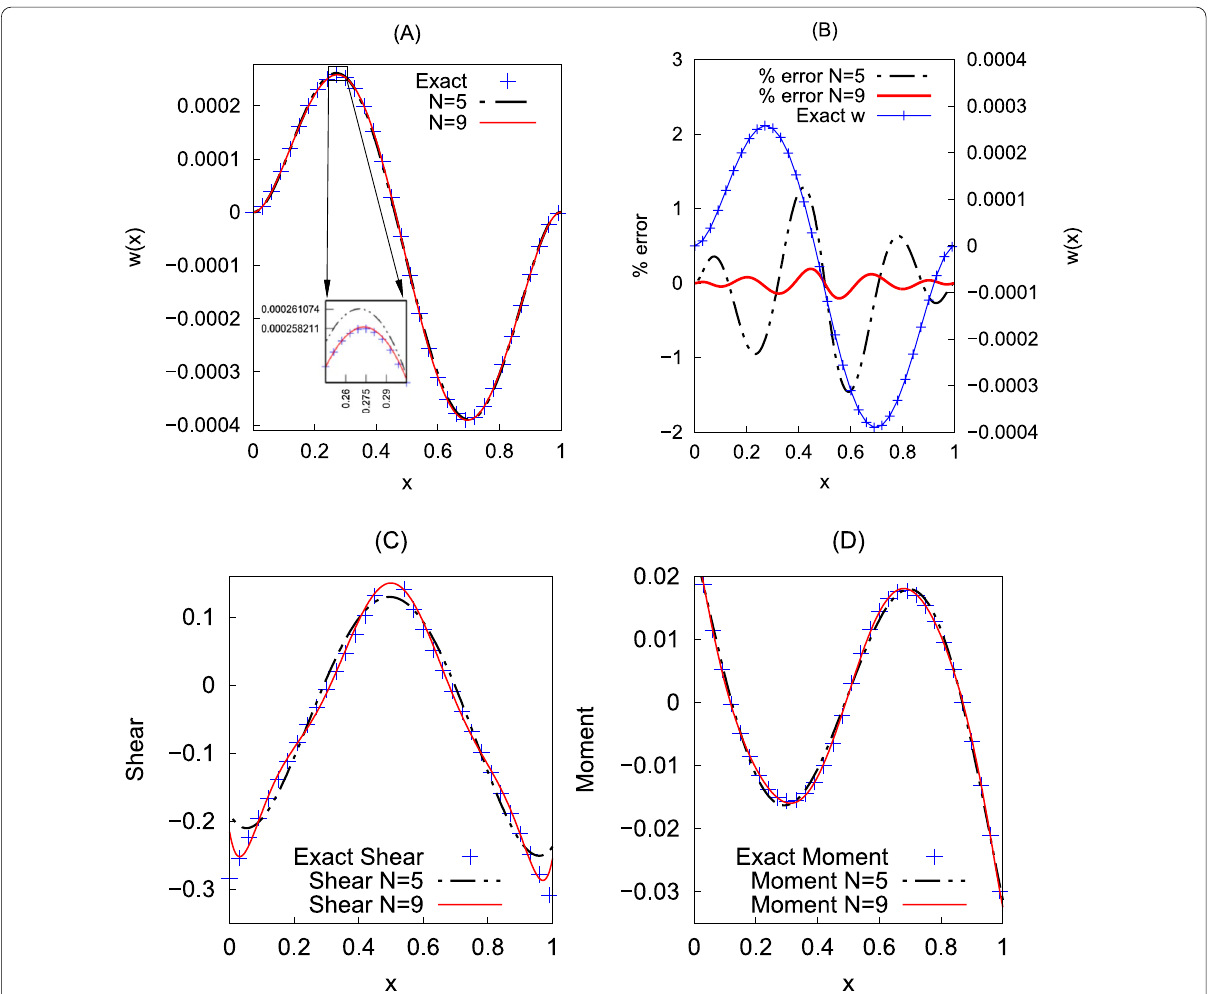
Fig. 7 Case (2) RRM and exact results. A Exact solution and RRM deflection. B Exact deflection and percentage error for various orders. C Exact and RRM shear. D Exact and RRM